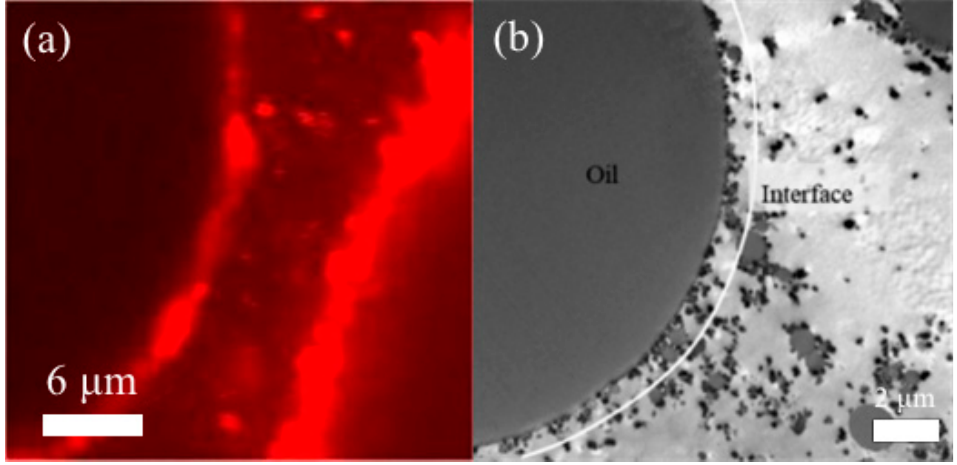
Figure 8. Particle disposition at the interface: ( a ) STED image of zein alcoholic protein stablized HIPE; ( b ) TEM image of droplet-stabilized emulsions. Adapted from [59,110] with permission from Elsevier Ltd, 2023.